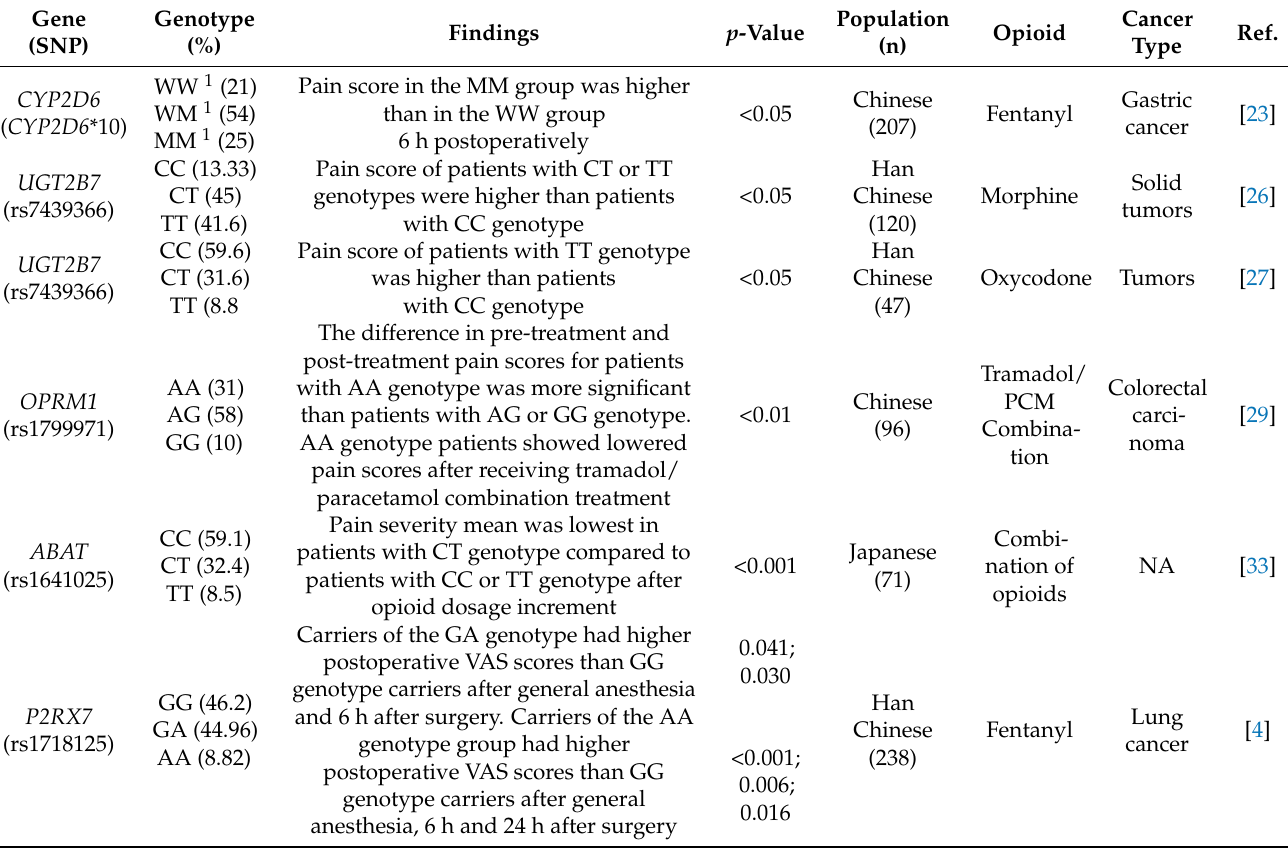
Table 5. Polymorphisms significantly associated with pain control in cancer pain among Asian